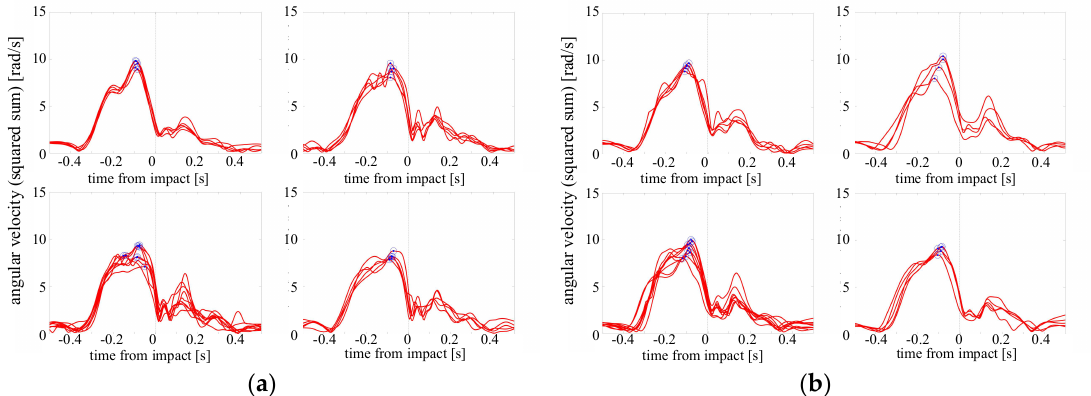
Figure 5. Trajectories of squared sum of angular velocity components aligned at impact time of one expert participant: ( a ) Baseline experiment (upper left: tee, upper right: toss (first), lower left: toss (med), lower right: toss (last)); ( b ) Feedback experiment (upper left: tee, upper right: toss (first), lower left: toss (with feedback), lower right: toss (last)). Each blue dot shows the detected peak of angular velocity in each trial.